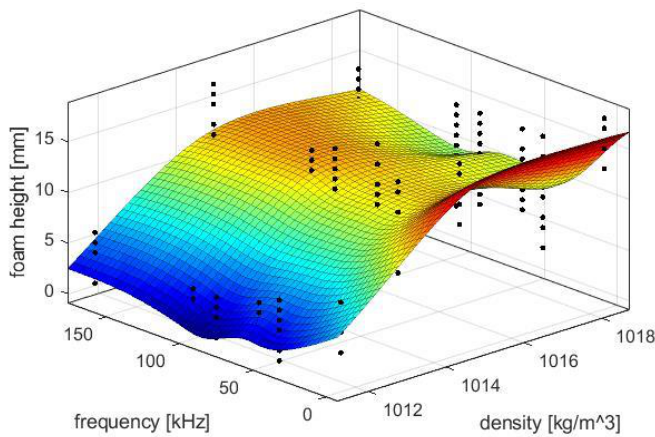
Figure 4. Resulting foam heights after filling at t = 8 s plotted against the density of the juice and the frequency used. frequency